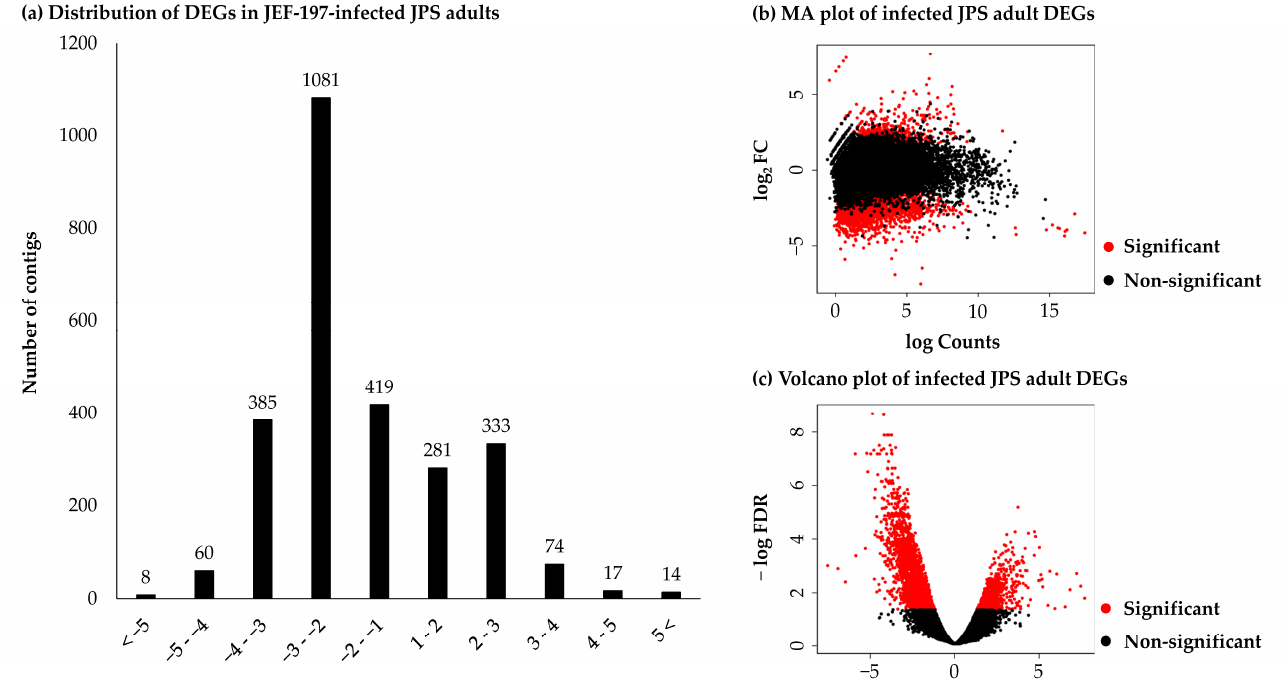
Figure 2. Distribution of differentially expressed genes in JPS adults infected with M. anisopliae JEF-197 based on fold change values (FDR < 0.05). The number of contigs for each FC (fold change) value of 1 was counted to assess changes in gene expression of JPS beetles treated with JEF-197. ( a ) Distribution of DEGs in M. anisopliae JEF-197-infected JPS adults. ( b ) MA plot of infected JPS adult DEGs. ( c ) Volcano plot of infected JPS adult DEGs.